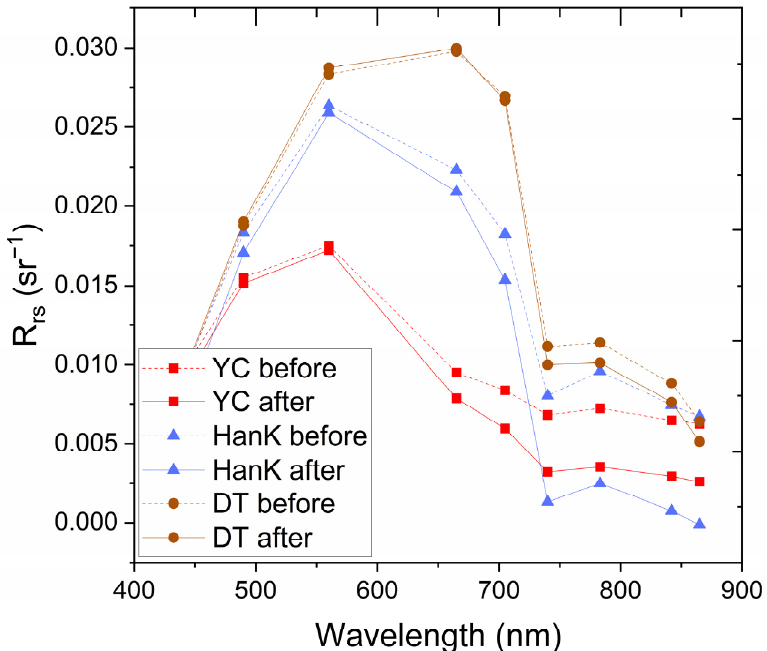
Figure 4. Differences in R rs at sampling points in the Yichang (YC), Hankou (HanK), and Datong (DT) reaches before and after correction for the adjacency effect.